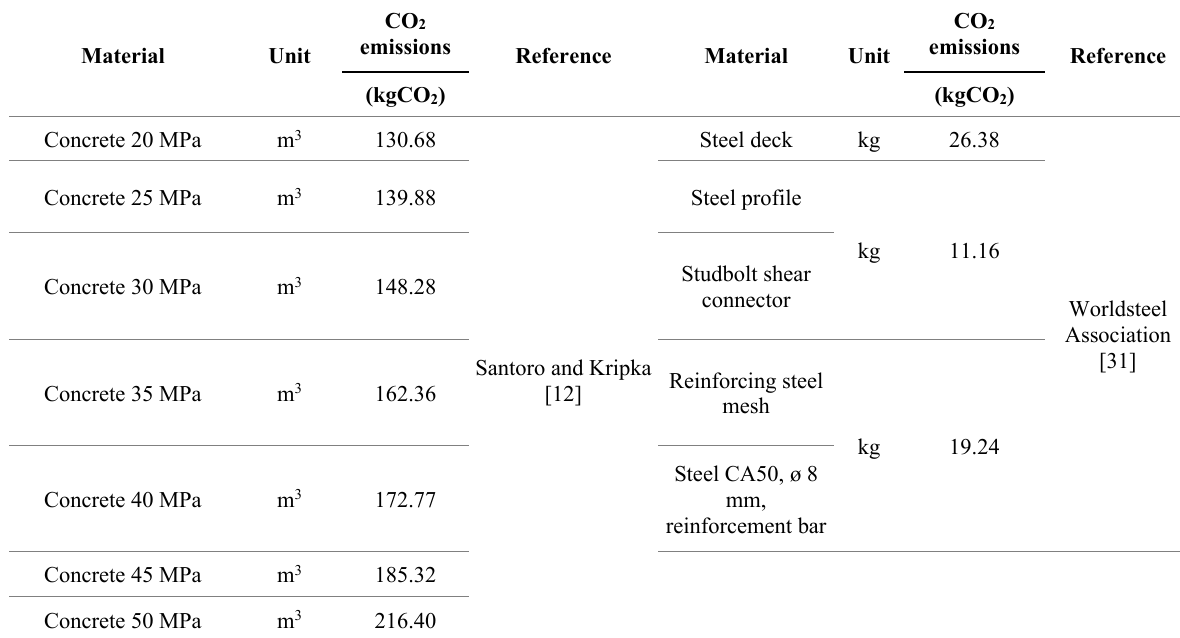
Table 1. CO 2 emission of